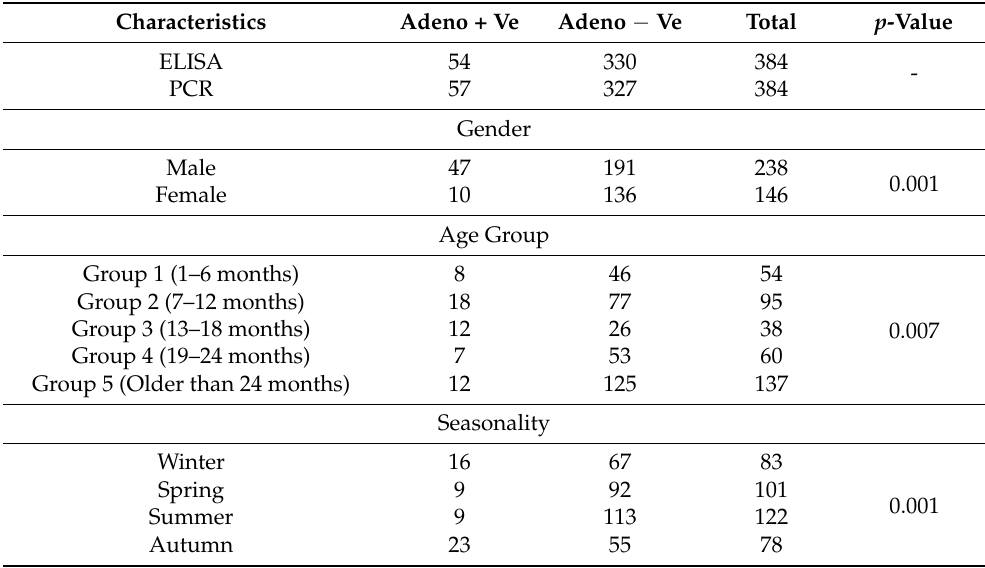
Table 2. Adenovirus detection by ELISA and Nested PCR in different gender, age groups and seasonality. Characteristics Adeno + Ve Adeno − Ve Total p -Value